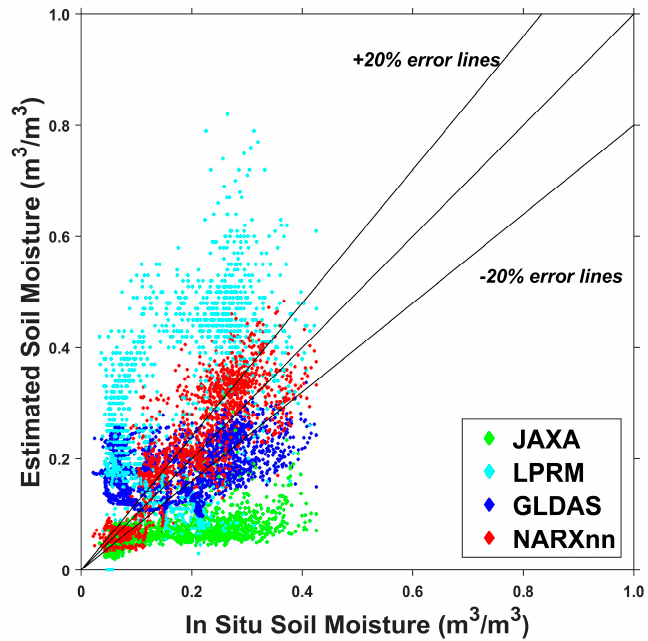
Figure 7. Scatter plot of in situ SM and the JAXA, LPRM, GLDAS and NARXnn SM products during the validation period (2015) for WATER-NET 1–4 and HM-NET 1–2.